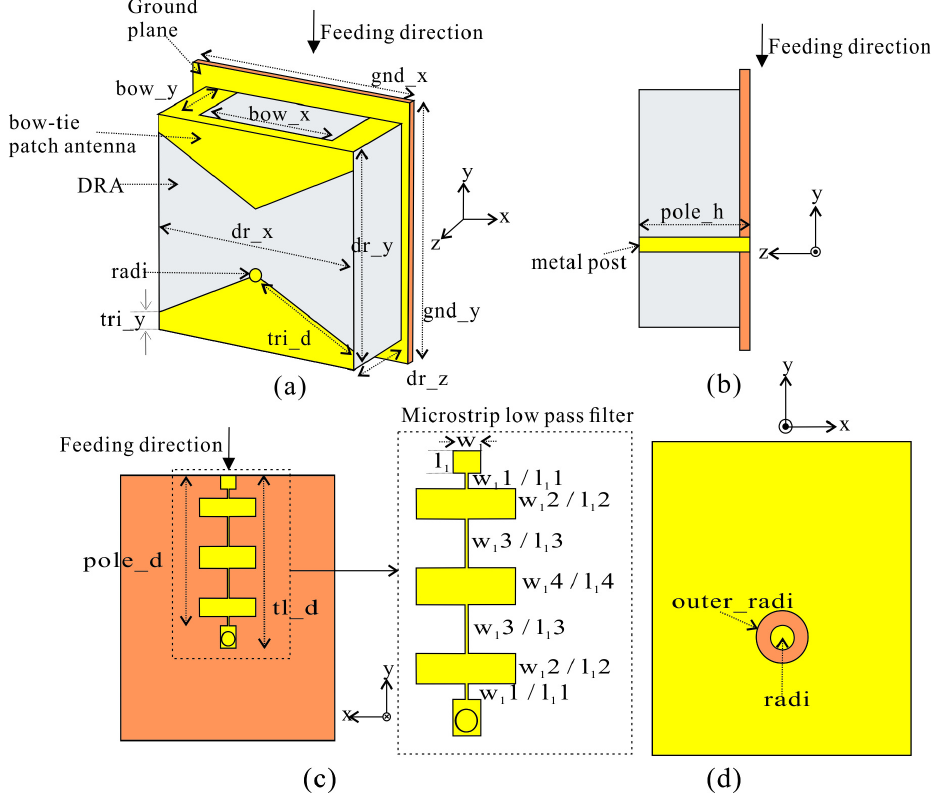
Figure 1. Configuration of the proposed antenna: ( a ) overall view; ( b ) side-cut view (yz plane); ( c ) back side-cut view of ground (xy plane); and ( d ) front side-cut view of ground. Table 1. Design parameters of the proposed antenna (unit: